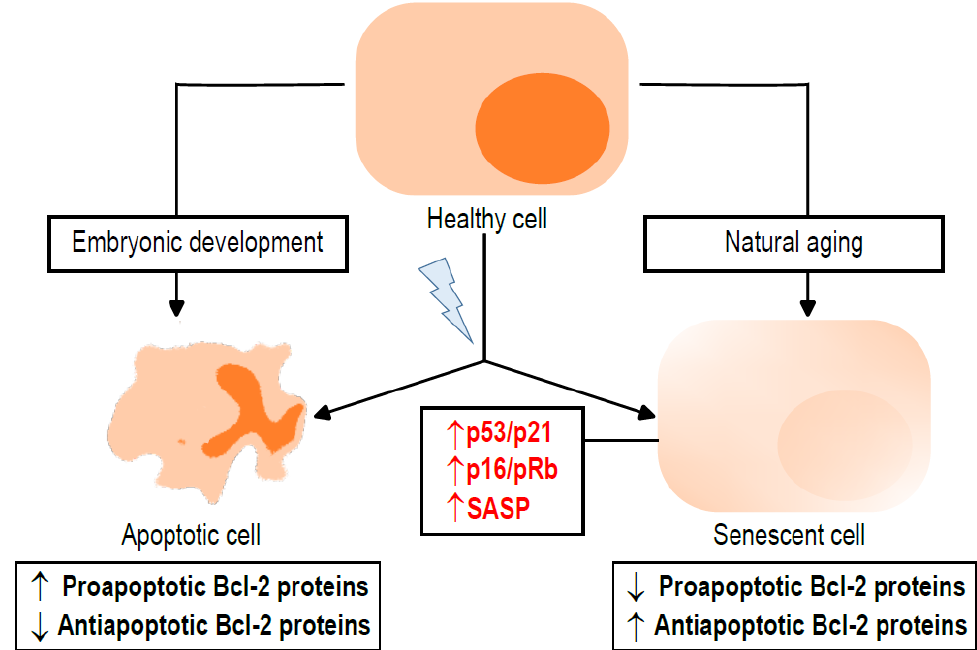
Figure 1. Apoptosis and senescence: two ways to suppress cell proliferation. Under physiological conditions, such as embryonic development or natural aging, healthy cells can enter apoptosis or senescence, respectively. However, apoptosis and senescence also play a role in pathophysiological situations. Certain stimuli can provoke stress signals, such as DNA damage or increased reactive oxygen species (ROS), leading to the suppression of cell proliferation by apoptosis or senescence. B-cell lymphoma 2 (Bcl-2) family proteins are differentially expressed in each case. Apoptosis is characterized by the increased expression of proapoptotic proteins and decreased expression of antiapoptotic proteins, whereas, in senescence, there is generally an increase in antiapoptotic proteins and a decrease in proapoptotic proteins. Likewise, senescent cells show an increase in senescent markers, such as activation of the p53/p21 Waf/Cip1 (p53/p21), p16 INK4a /retinoblastoma protein (p16/pRb) and senescence-associated secretory phenotype (SASP) pathways. Up arrows mean increase, down arrows mean decrease. Black arrows are related to Bcl-2 family proteins, while red arrows are related to senescence hallmarks.